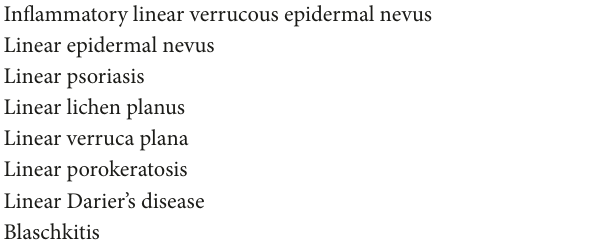
Table 1: LS differential diagnosis [1,